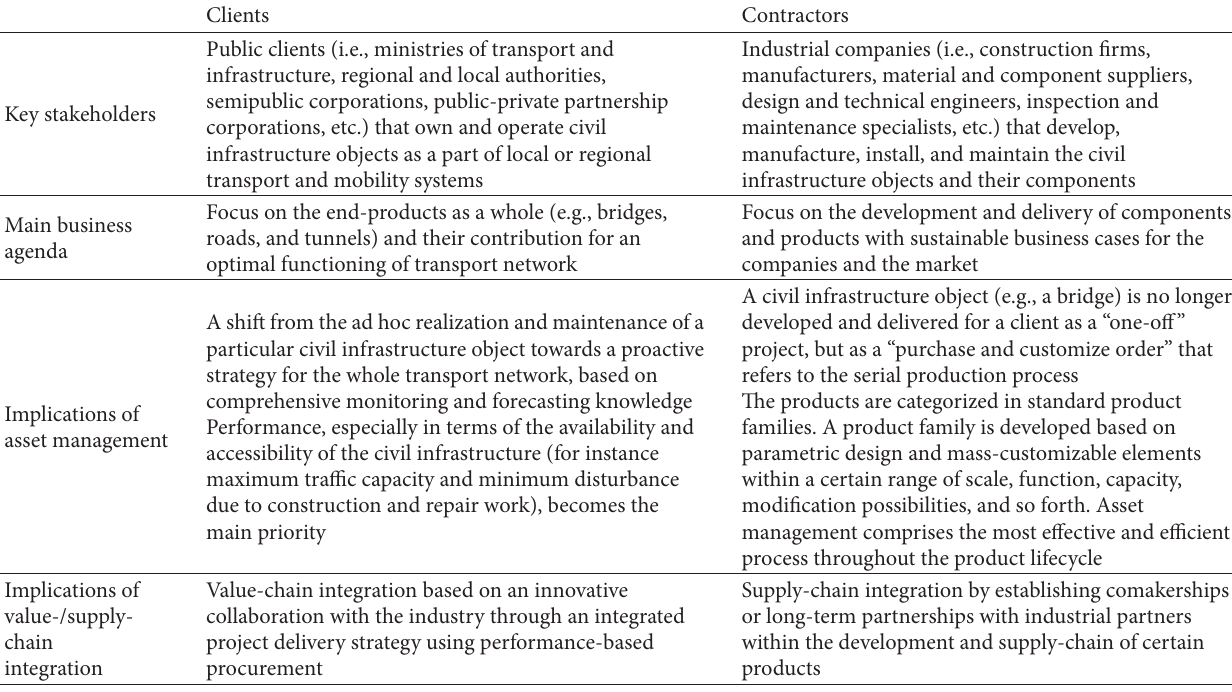
Table 1: Main subjects for the analysis of asset management for clients and